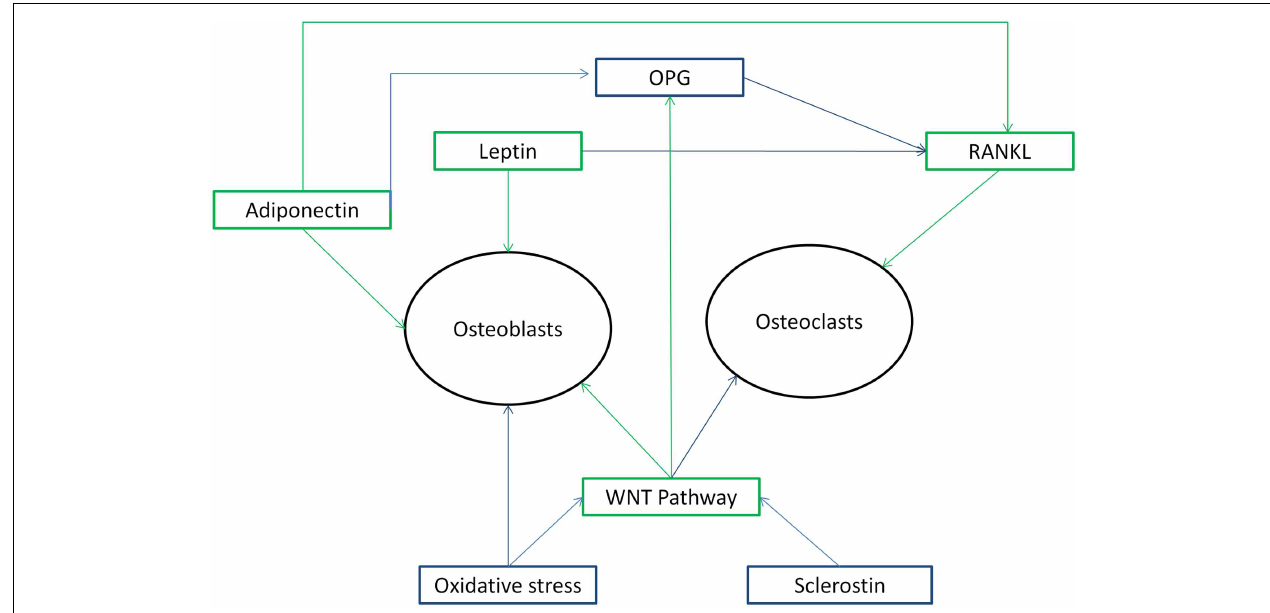
shows that the systems regulating bone metabolism are in a complex relationship to each other. Green arrows indicate a stimulating action, while blue arrows indicate a inhibiting